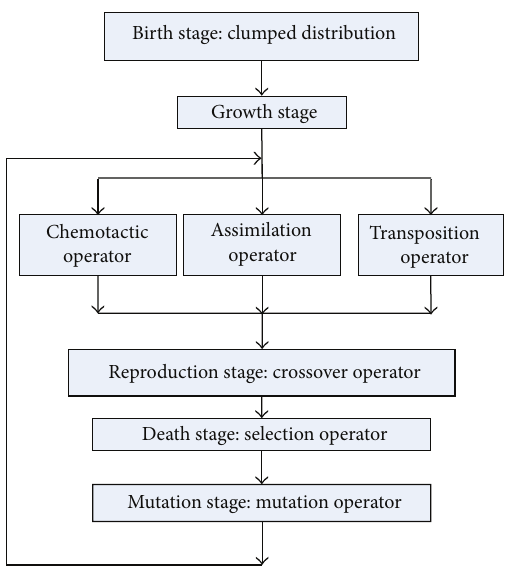
Figure 1: LSO algorithm